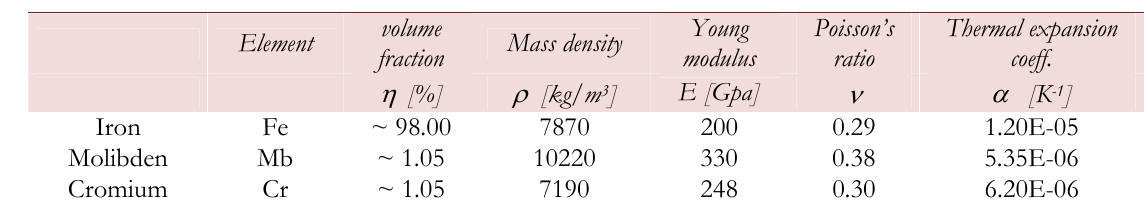
Table 1: Physical and mechanical parameters of the main elements in a carbon steel D6ac.